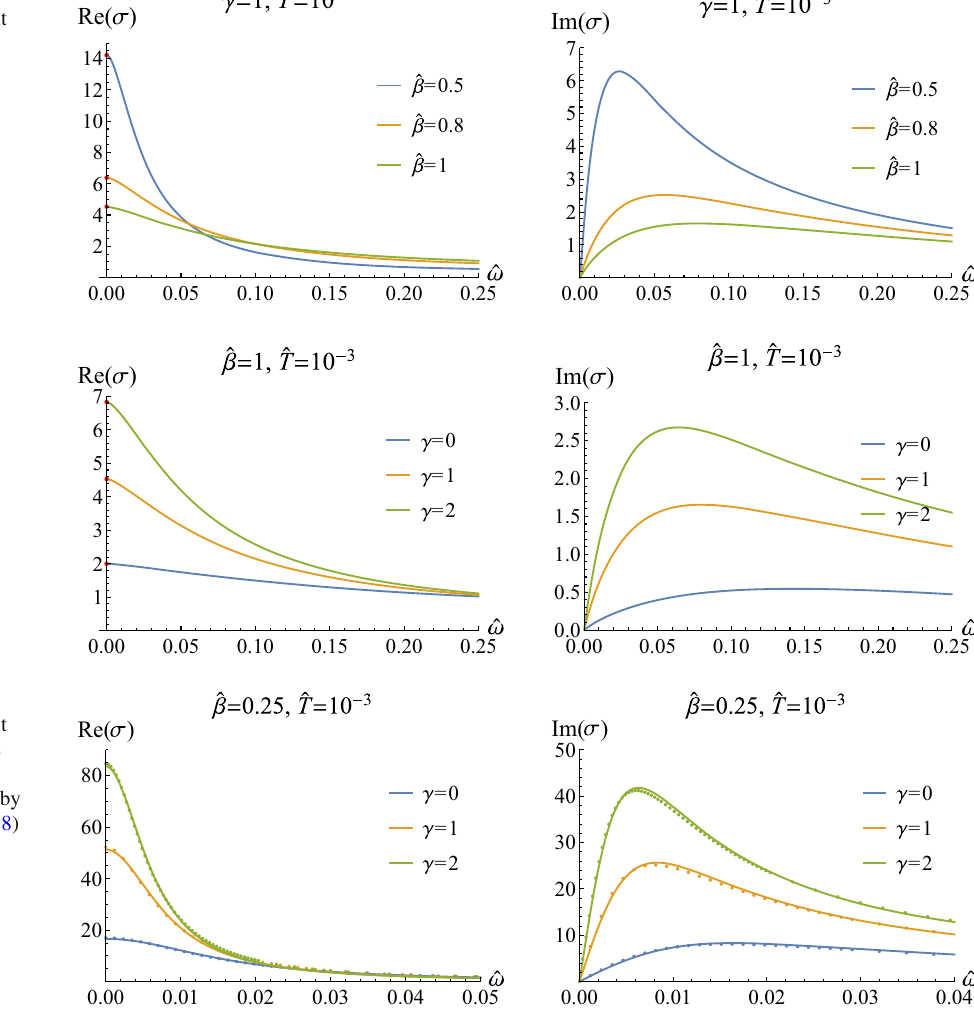
Fig. 5 The electric conductivity σ( ˆ ω) for different ˆ β and γ